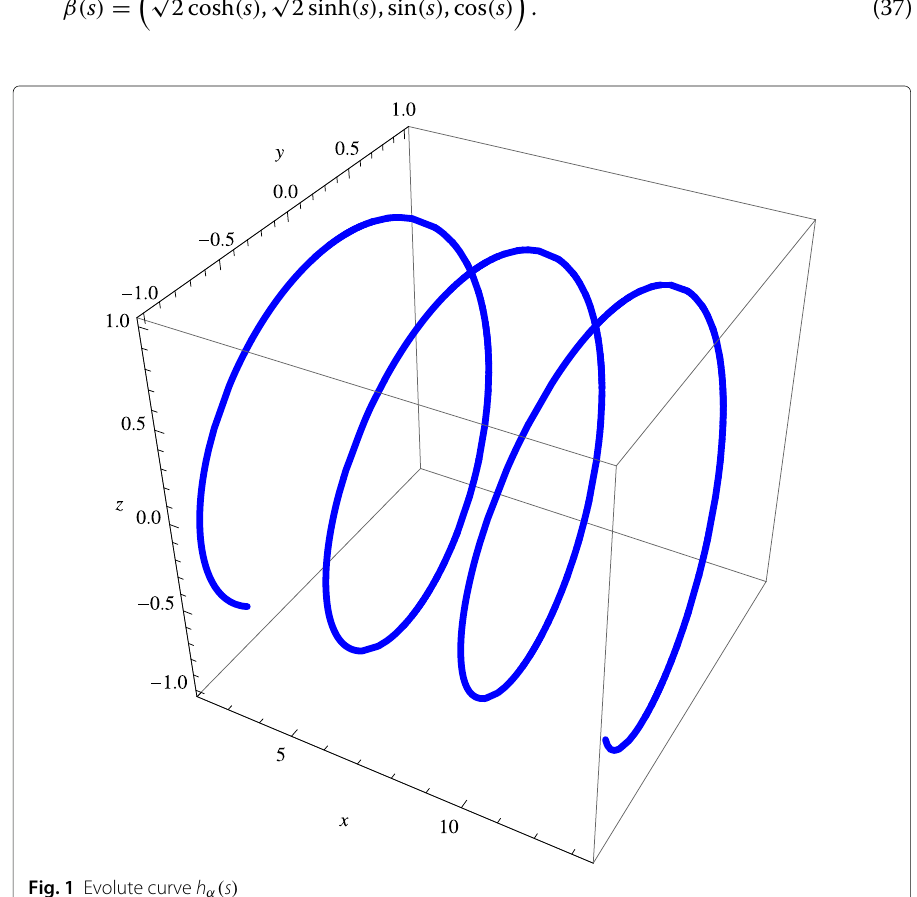
Fig. 1 Evolute curve h α ( s